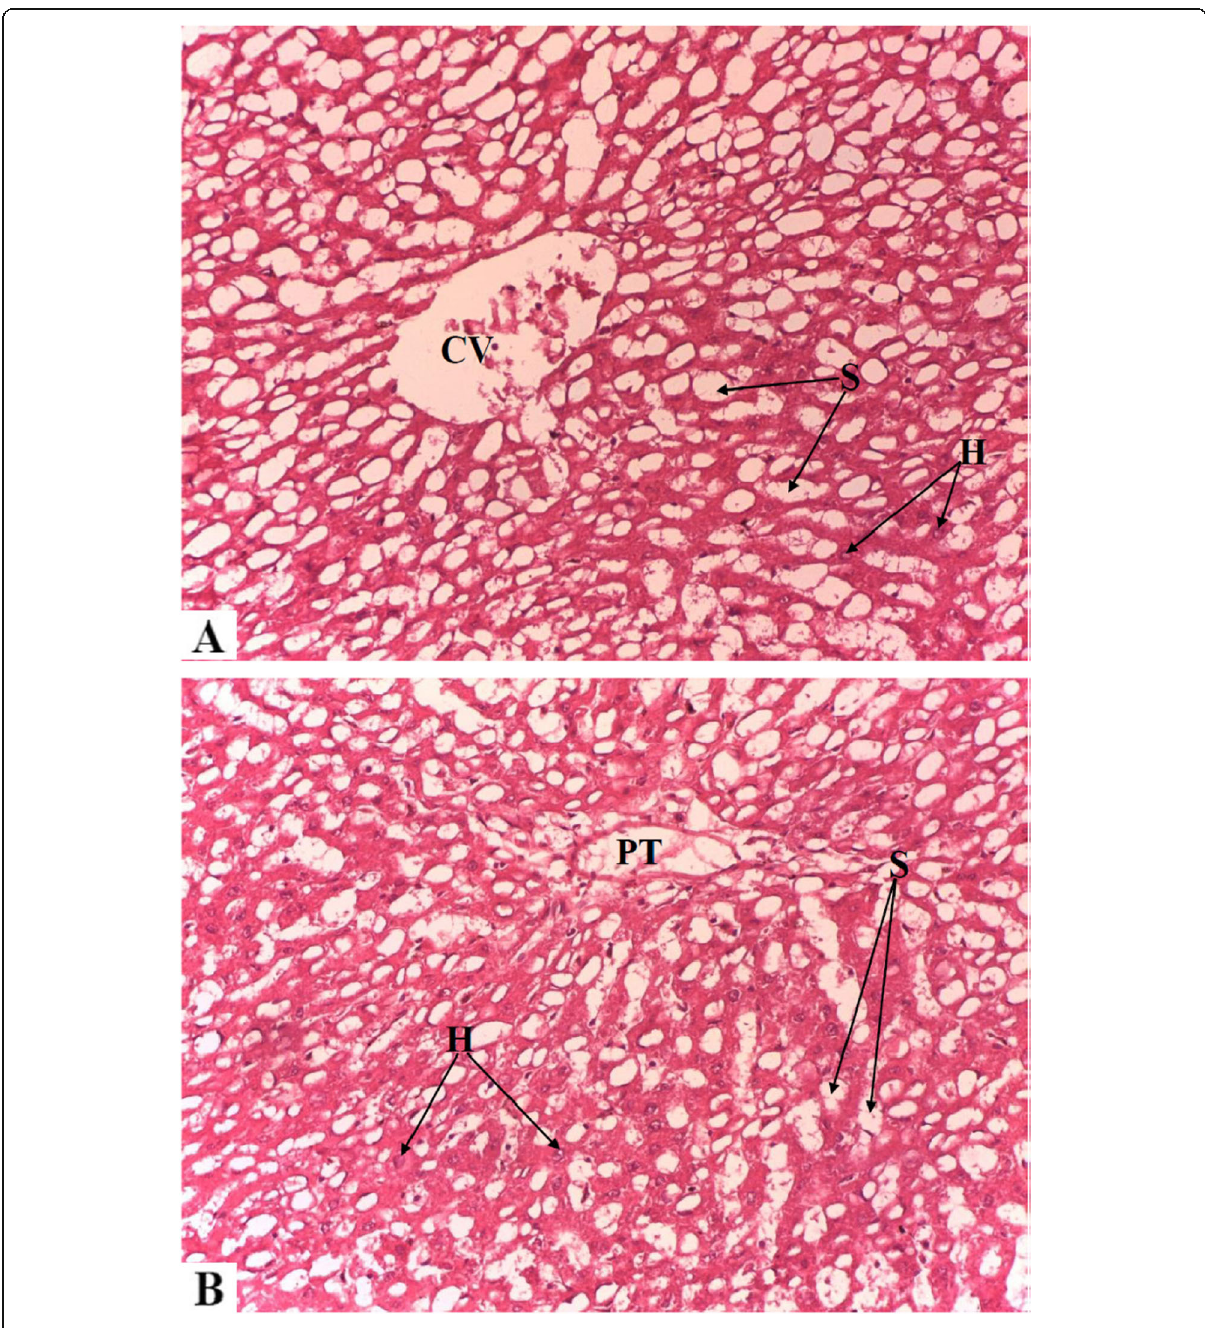
Fig. 5 Photomicrographs of liver section of rat administered ethanolic seeds ’ extract of P. guineense (100 mg/kg bw) showing normal sinusoids (S), portal tract (PT), central vein (CV). and hepatocytes